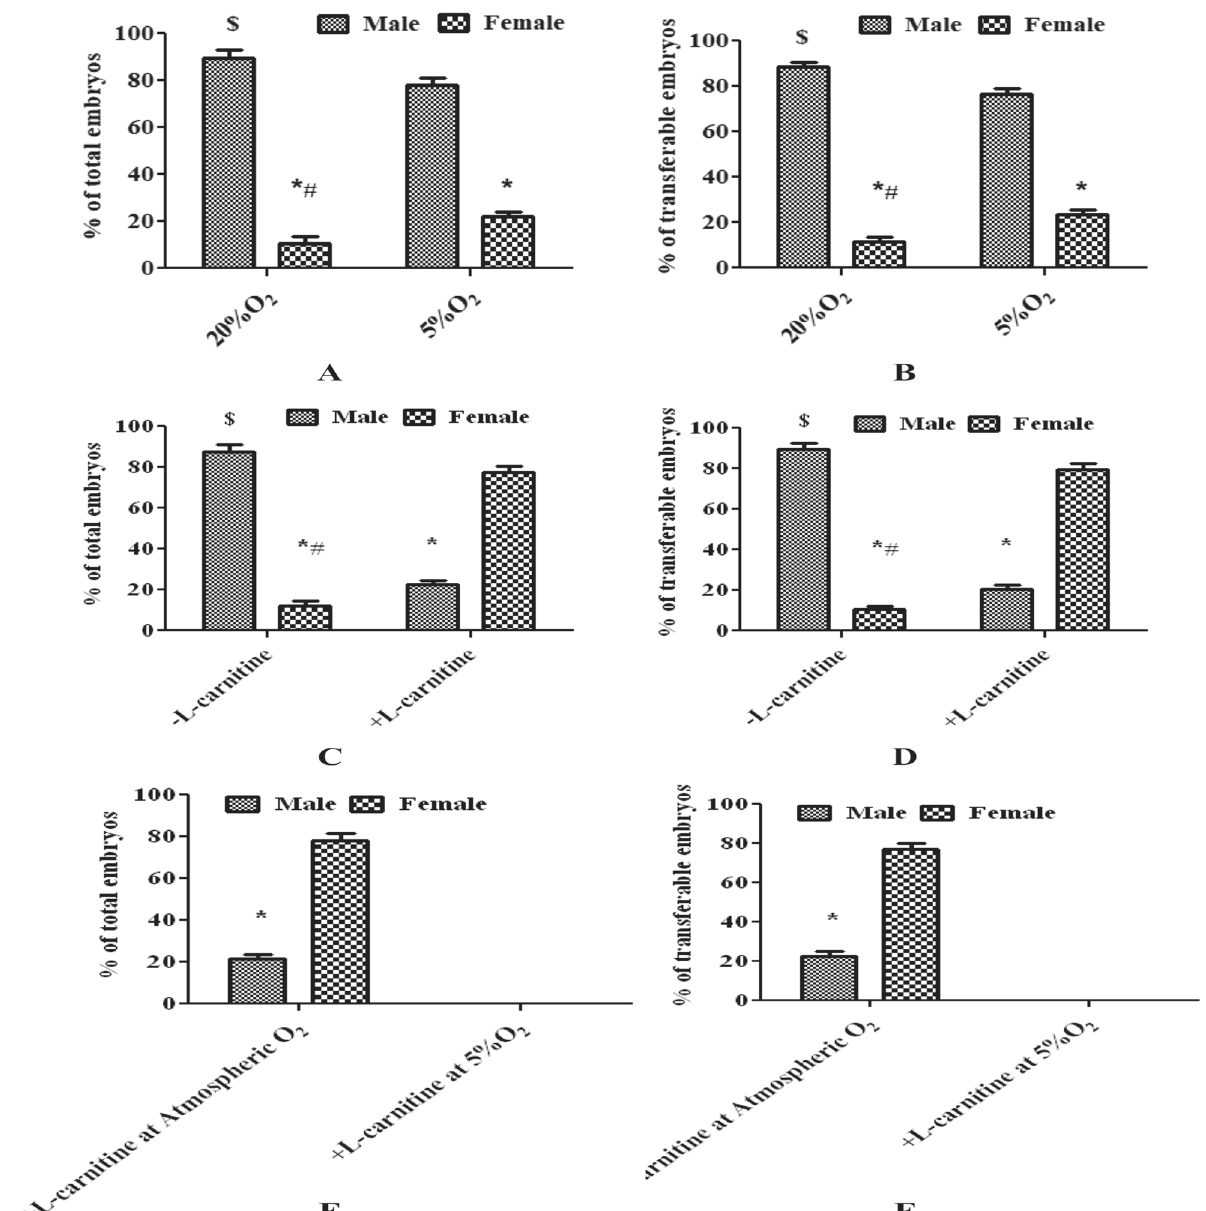
Figure 4. Sex ratio of the embryos produced in different experiments (I–III). ( A ) Sex ratio of the total embryos produced in experiment I. ( B ) Sex ratio of the transferable embryos produced in experiment I. ( C ) Sex ratio of the total embryos produced in experiment II. ( D ) Sex ratio of the transferable embryos produced in experiment II. ( E ) Sex ratio of the total embryos produced in experiment III. ( F ) Sex ratio of the transferable embryos produced in experiment III. *Significant difference between male and female of each group at P < 0.05. $ Significant difference between the males of both the groups at P < 0.05. # Significant difference between the females of both the groups at P <